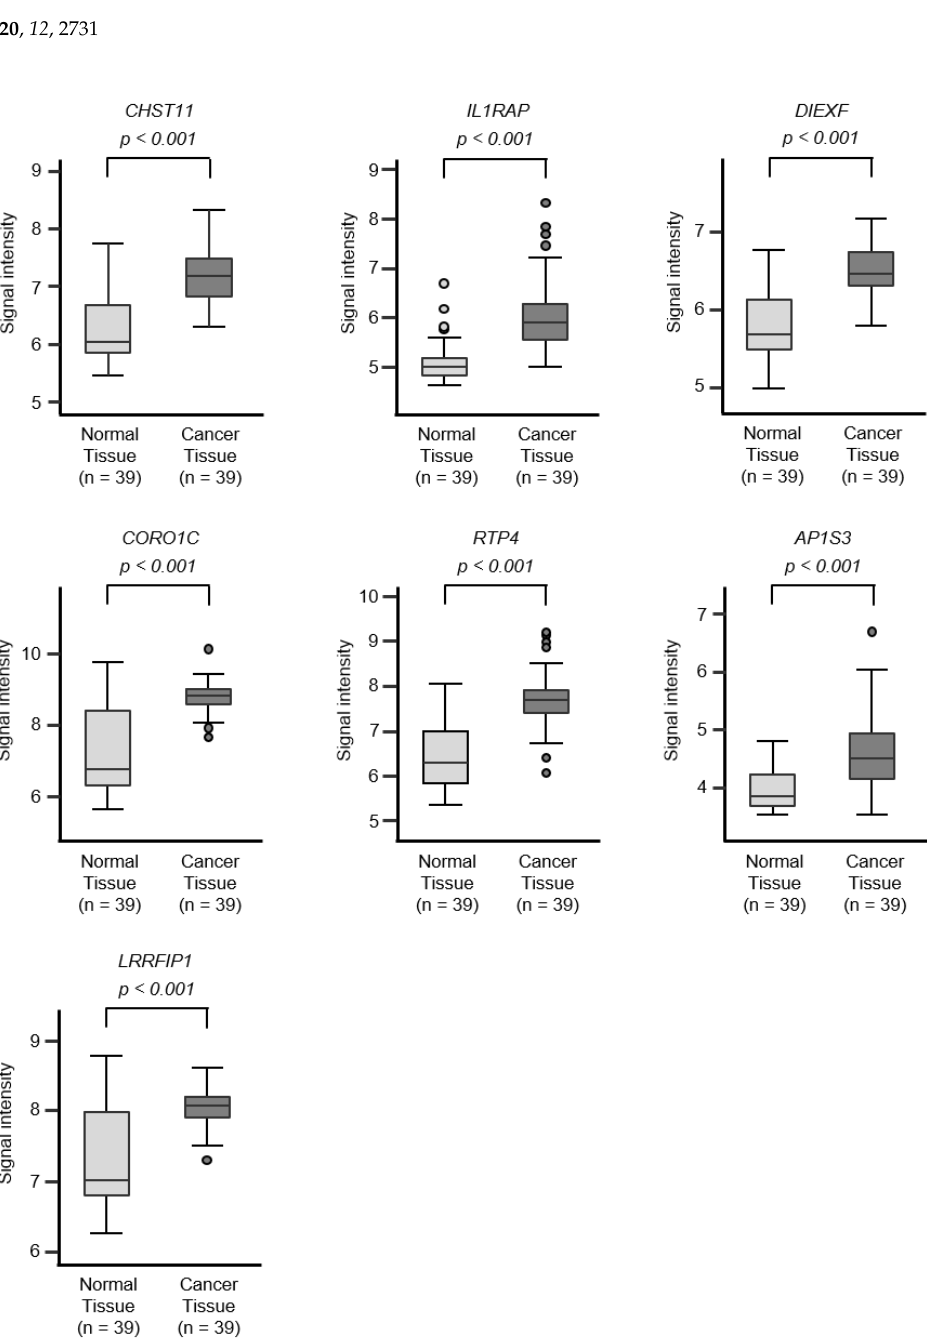
Figure 4. Expression levels of 18 target genes (that predicted 5-year survival) by miR-30c regulation in PDAC clinical specimens by TCGA analyses. Expression levels of 18 target genes of miR-30c (Figure 3) were evaluated using TCGA database analyses. All genes were found to be upregulated in PDAC tissues ( n = 39) compared to normal tissues ( n = 39).